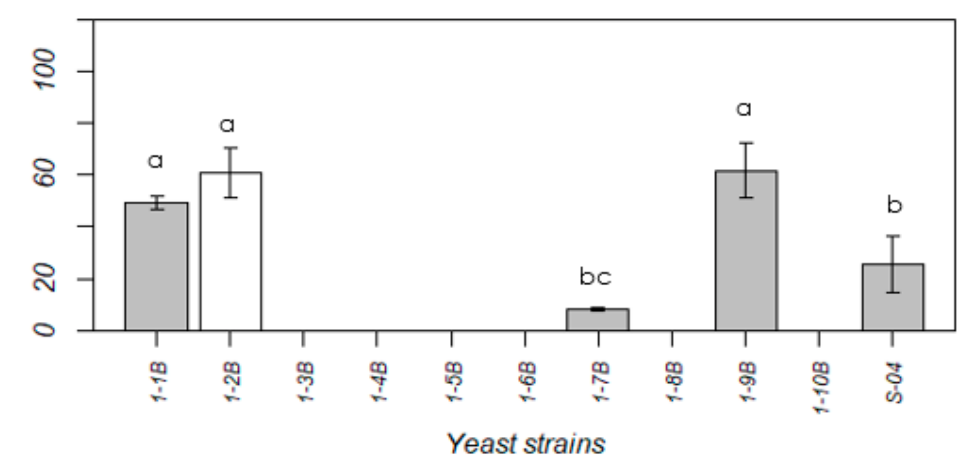
Figure 2. Melatonin production by 10 L. thermotolerans strains and S-04 in 100 mL fermentation. Data with different superscript letters are significantly different (Tukey tests: p < 0.05).